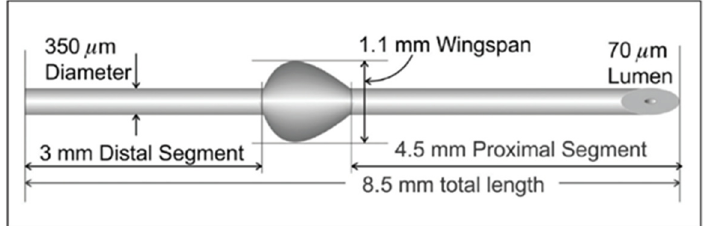
Figure 1. Preserflo MicroShunt (copyright Santen Pharmaceutical Co., Ltd., Osaka, Japan; reproduced with